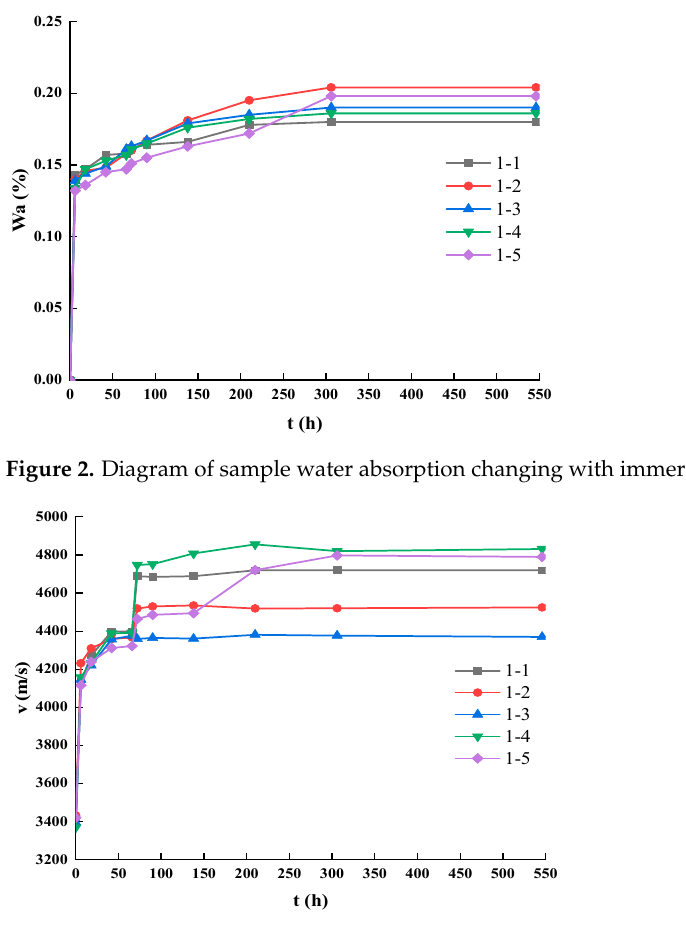
Figure 3. Curve diagram of P-wave velocity of sample changing with water immersion time.